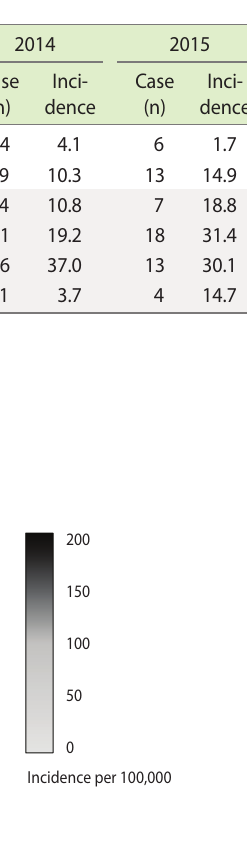
Figure 1. Regional incidence of scrub typhus by year. 1, Jeju-si; 2, Seogwipo-si; 3, Jocheon- eup; 4, Gujwa-eup; 5, Udo-myeon; 6, Aewol-eup; 7, Hallim-eup; 8, Hangyeong-myeon; 9, Seongsan-eup; 10, Pyoseon-myeon; 11, Namwon-eup; 12, Daejeong-eup; 13,